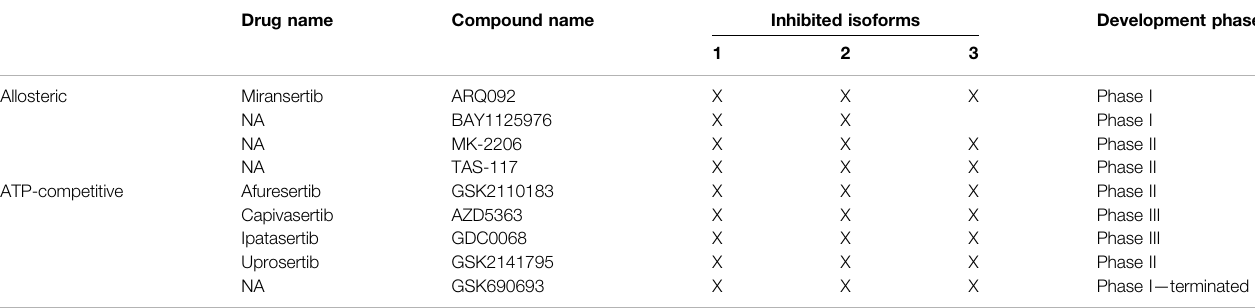
TABLE 1 | Selected AKT inhibitors and their main